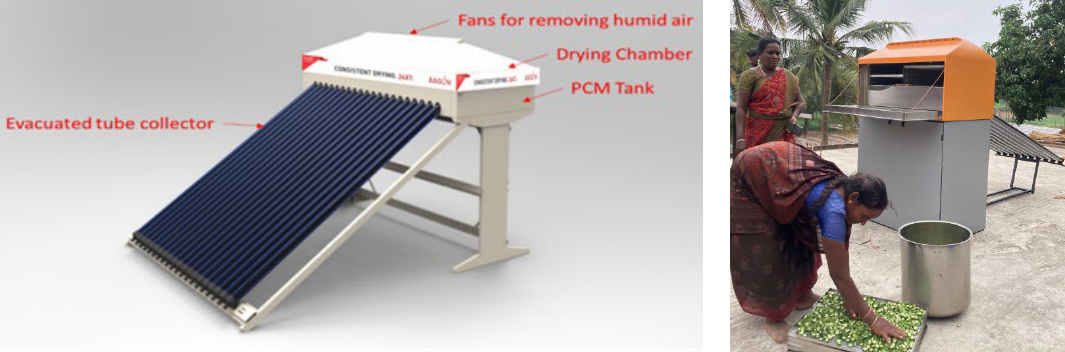
Figure 5. Solar dryer with PCM, for drying agriculture produce (source: PLUSS Advanced Technologies Ltd.).